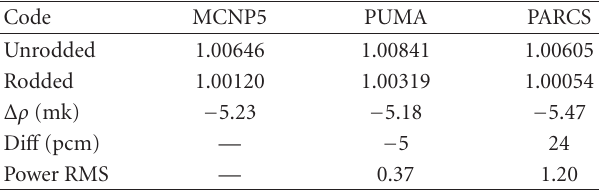
Table 7: TCNA-I idealized core—steel rods.